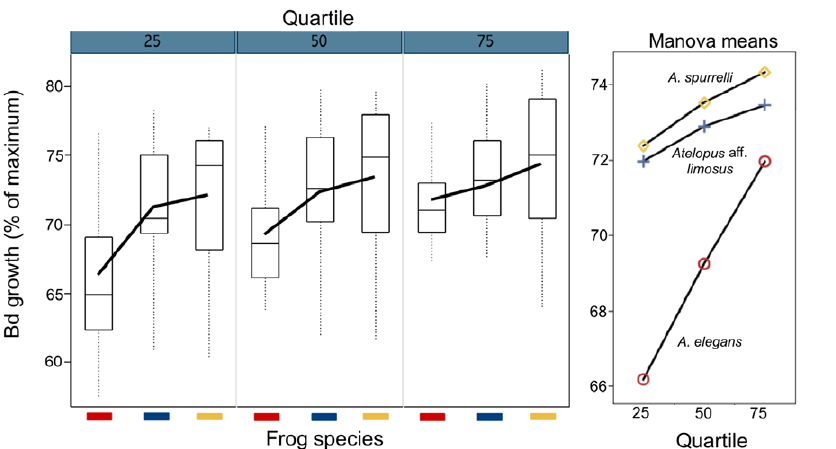
Figure 2. Differences in Bd -growth averaged from all anti- Bd bacterial isolates on each frog species (color code). Growth is estimated at three distances (quartiles 25, 50 and 75) from the bacteria by using spline regression models. Left: original variation as summarized by boxplots and average lines. Right: means for each frog-quartile combination as estimated from the corresponding Manova model. Atelopus elegans is the only species we found infected with Bd in its natural habitat.